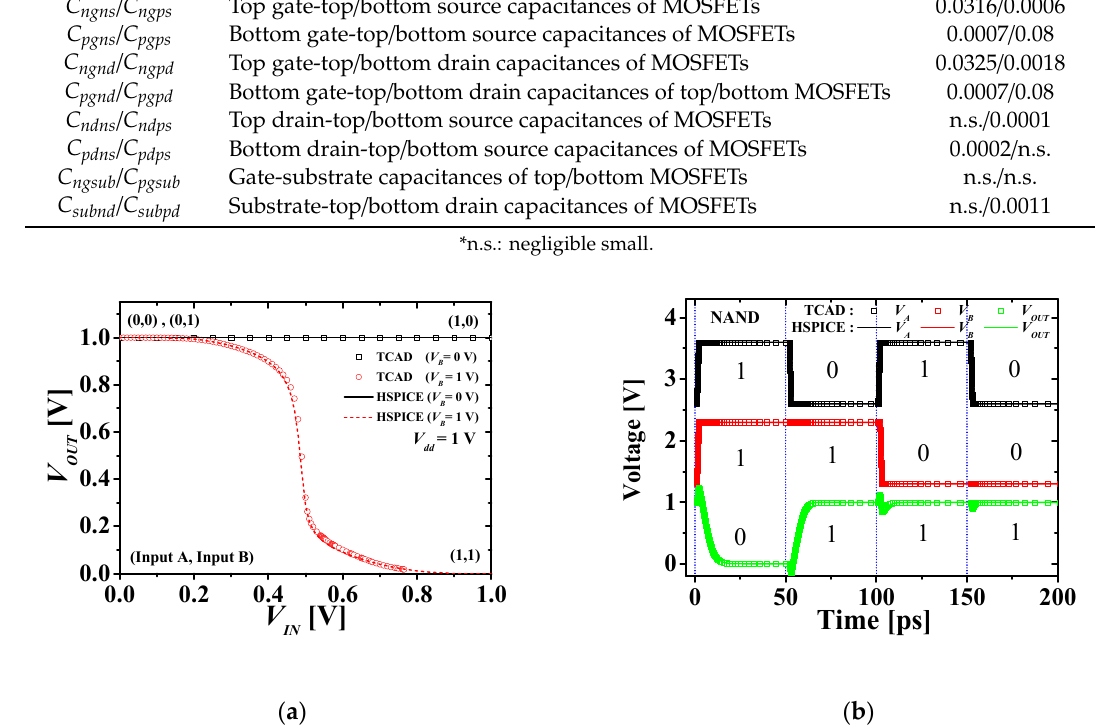
Figure 6. Comparison of ( a ) VTCs and ( b ) transient responses with TCAD mixed-mode and HSPICE of M3DNAND.